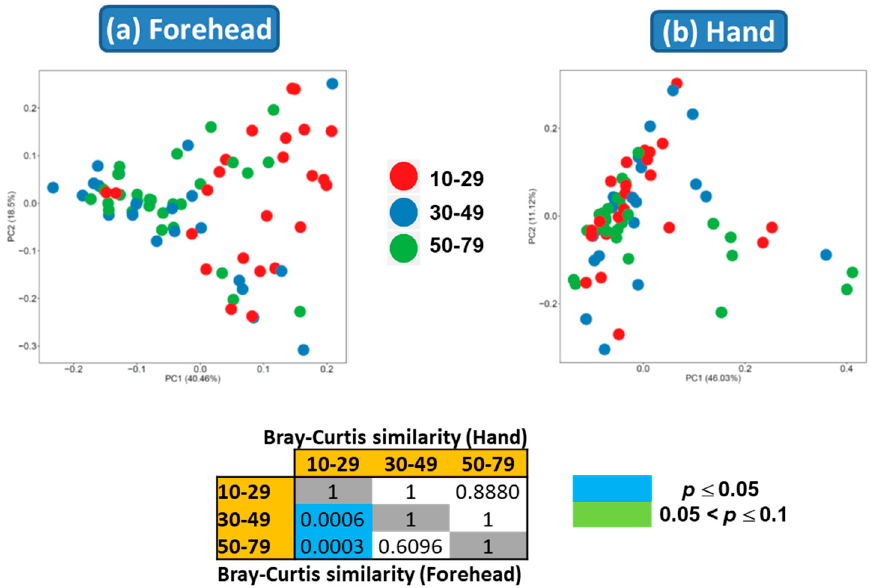
Figure 5. Functional distribution of Kyoto Encyclopedia of Genes and Genomes (KEGG) orthologs on the ( a ) forehead skin and ( b ) hand skin among age groups. Non-parametric Permutational Multivariate Analysis of Variance (PERMANOVA) was used to compare the function distribution of KEGG orthologs among the age groups. Table 5. Di ff erentially abundant major functions within MetaCyc pathways by Age